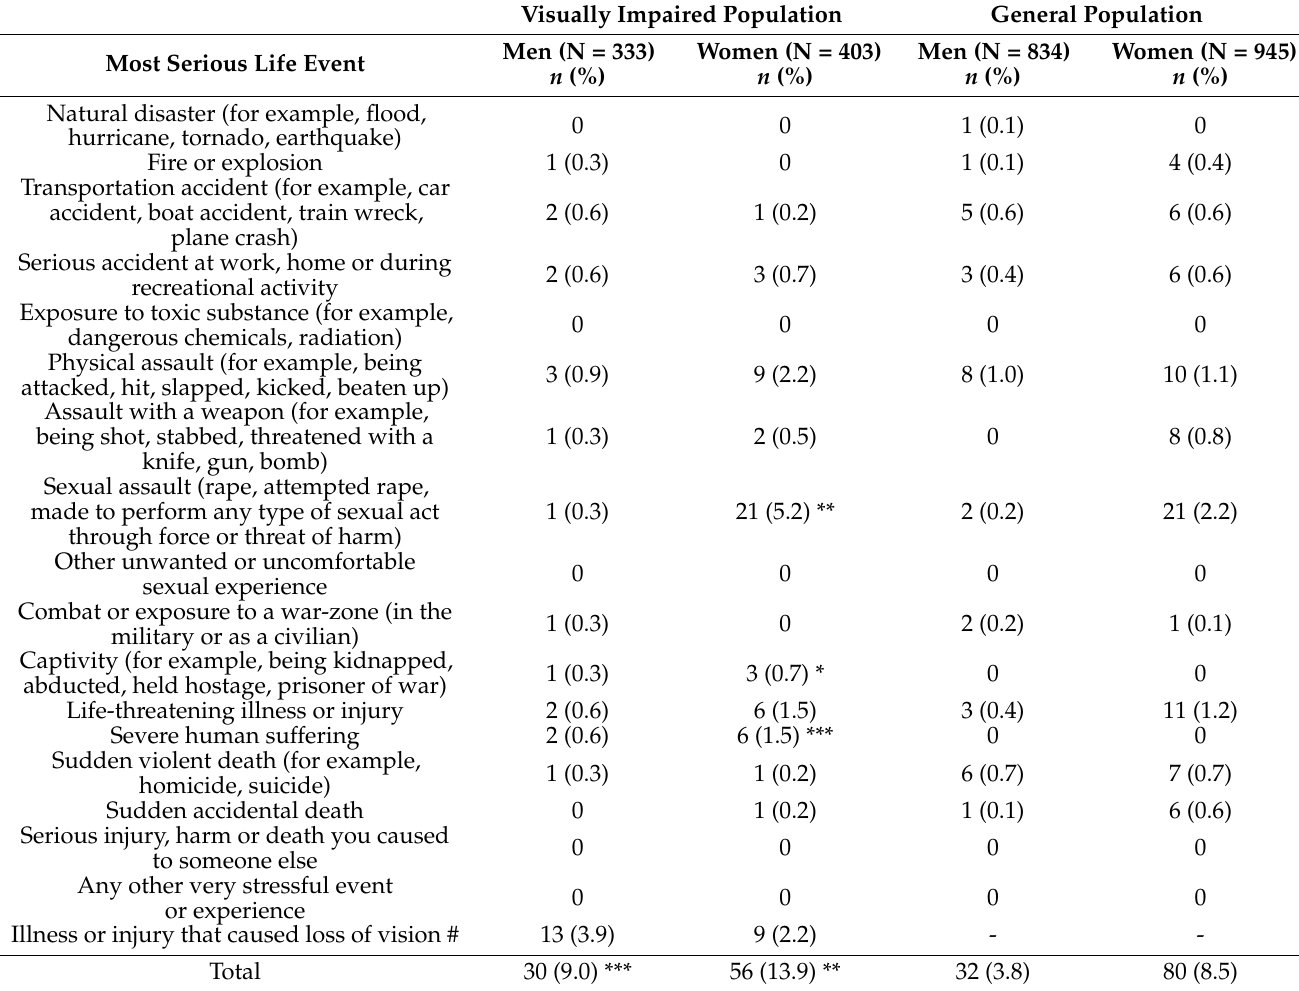
Table 2. Current PTSD caused by serious life events (VI n = 736 and GP n = 1792). Visually Impaired Population General